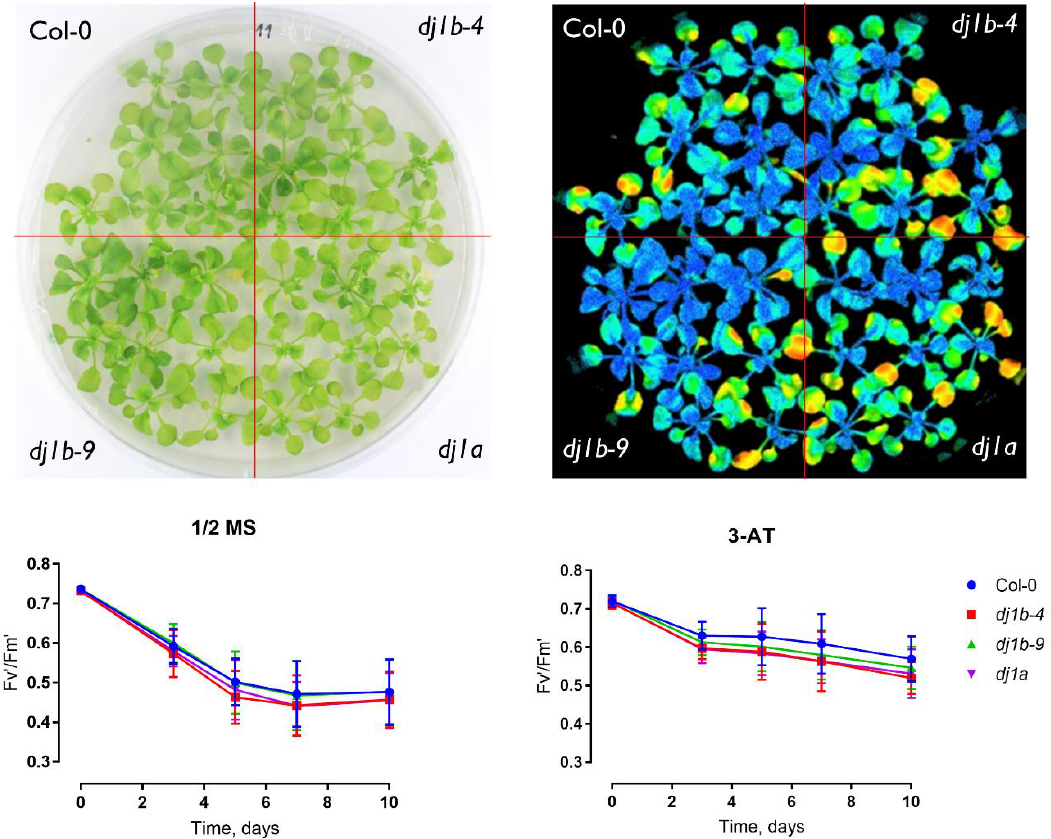
Figure 8. Plants deficient in AtDJ-1A orAt DJ-1B show no photorespiratory phenotype. (Upper panel) T-DNA dj1a and dj1b insertion lines do not differ from WT, as shown on a representative bright-light image (left) and color-coded Fv’/Fm’ image (right) after 7 days of Restricted Gas exchange and Continuous Light (RGCL) treatment. (Lower panel) Fv’/Fm’ decrease during the RGCL treatment. Data points represent averages from biological replicates ± SD.